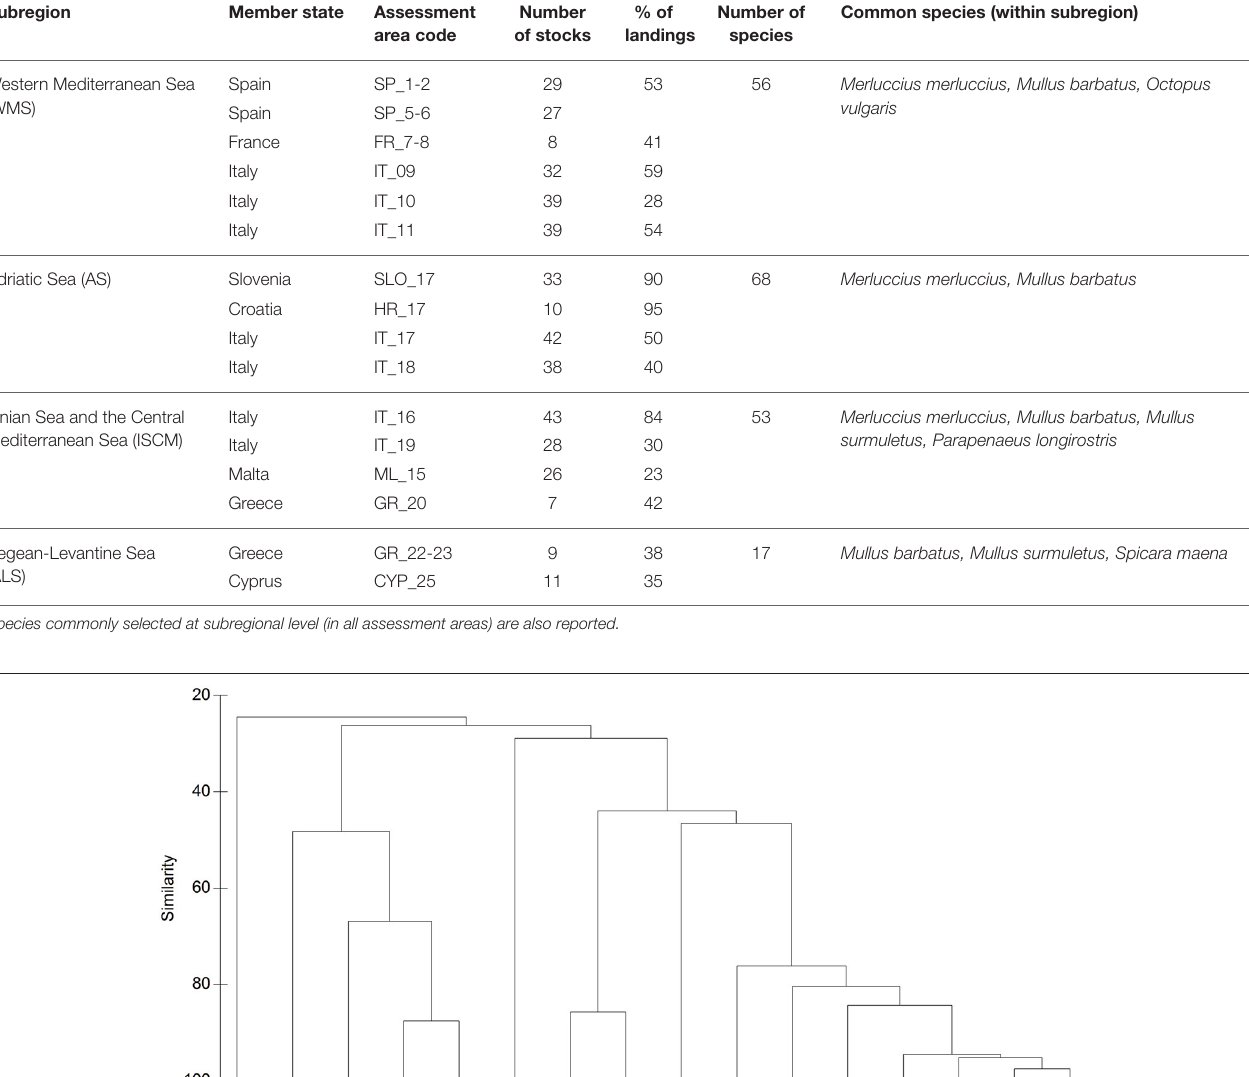
TABLE 3 | Number of stocks, species, and the corresponding percentage of landings considered within Initial Assessment in all Mediterranean assessment